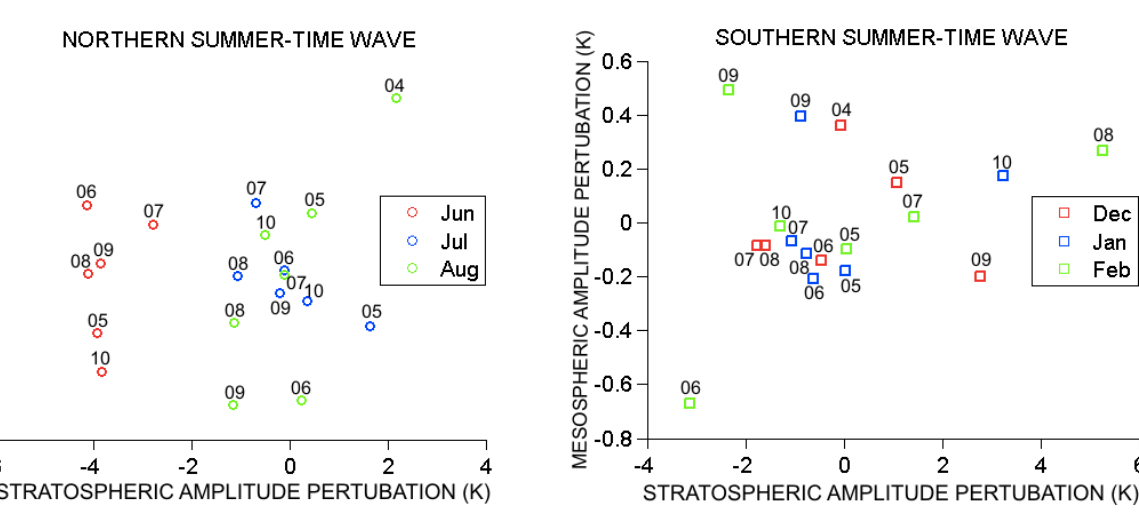
Fig. 7. Composite-month temperature amplitudes for the 16-day wave in each month of the year, August 2004–May 2010. Also plotted are the UKMO composite monthly-mean zonal winds (ms − 1 ) as contour lines and the stratopause height as a red contour line.